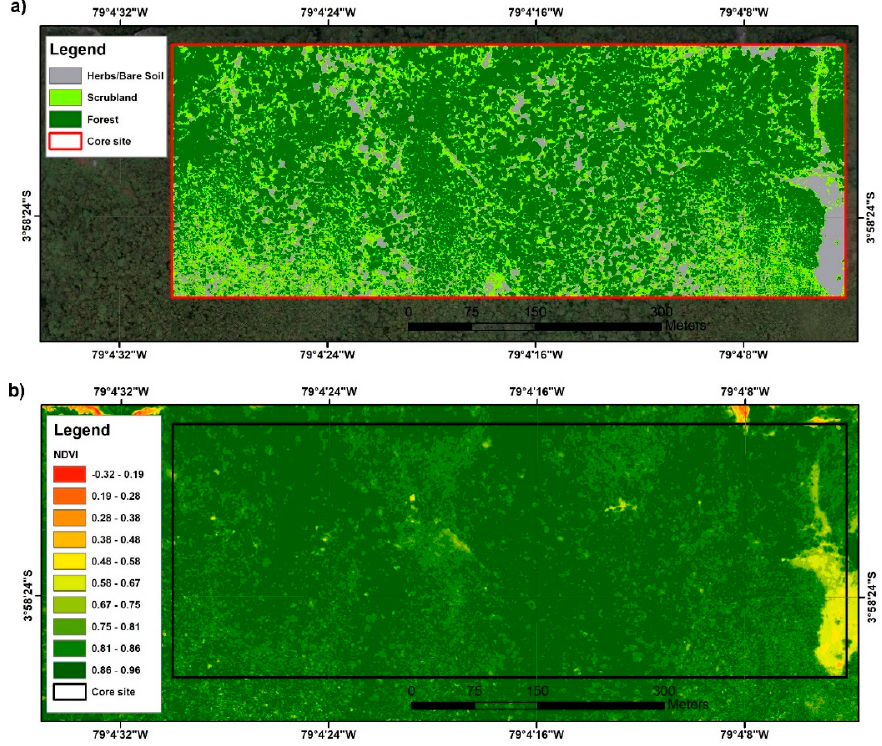
Figure 7. Multispectral data obtained by the multispectral camera, ( a ) non-supervised classification based on the false color composition image and ( b ) NDVI values.